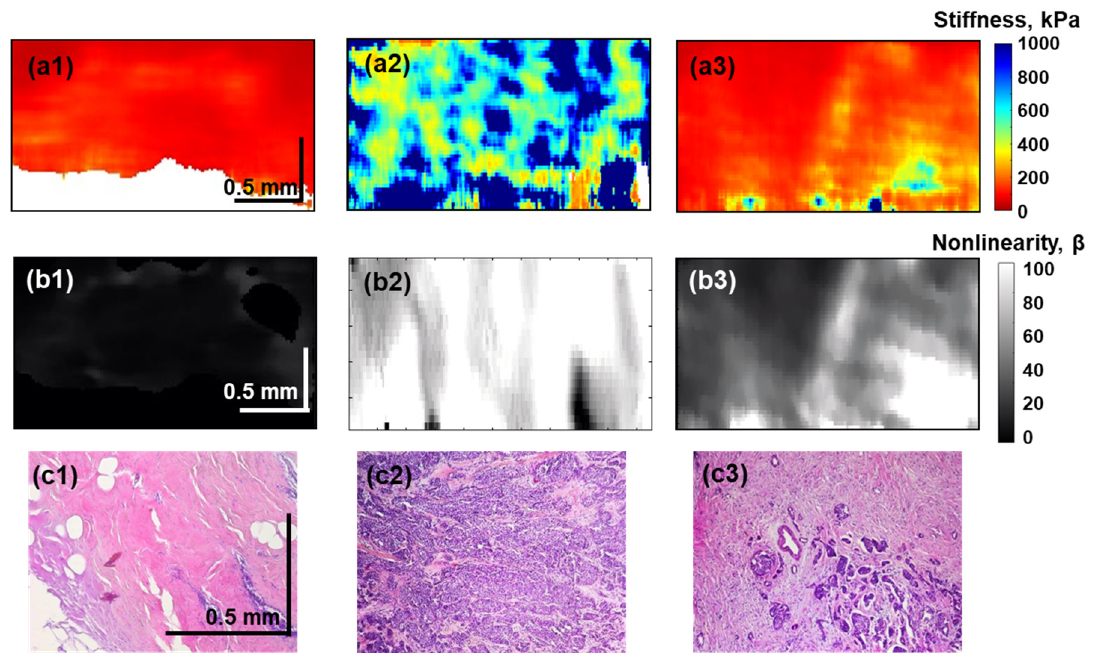
Figure 4. OCE-based visualization of the Young’s modulus E 0 ( row ( a )) and the nonlinearity parameter β (row ( b )) obtained for low pressure 0.5 ± 0.5 kPa applied to the tissues, for which the corresponding histological images are shown in row ( c ). ( a1 – c1 ) is a benign fibroadenoma, ( a2 – c2 ) is a malignant tumor of solid type and ( a3 – c3 ) is a malignant tumor of scirrhous type. Notice that benign fibrosis and scirrhous tumor exhibit very similar stiffness (compare panels ( a1 , a3 )), but distinctly different nonlinearity parameters (panels ( b1 , b3 )).